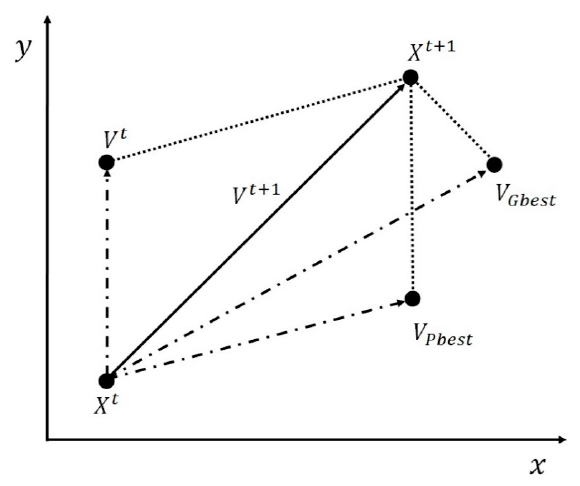
Figure 2 . Updating Position using PSO [19]. Figure 2. Updating Position using PSO